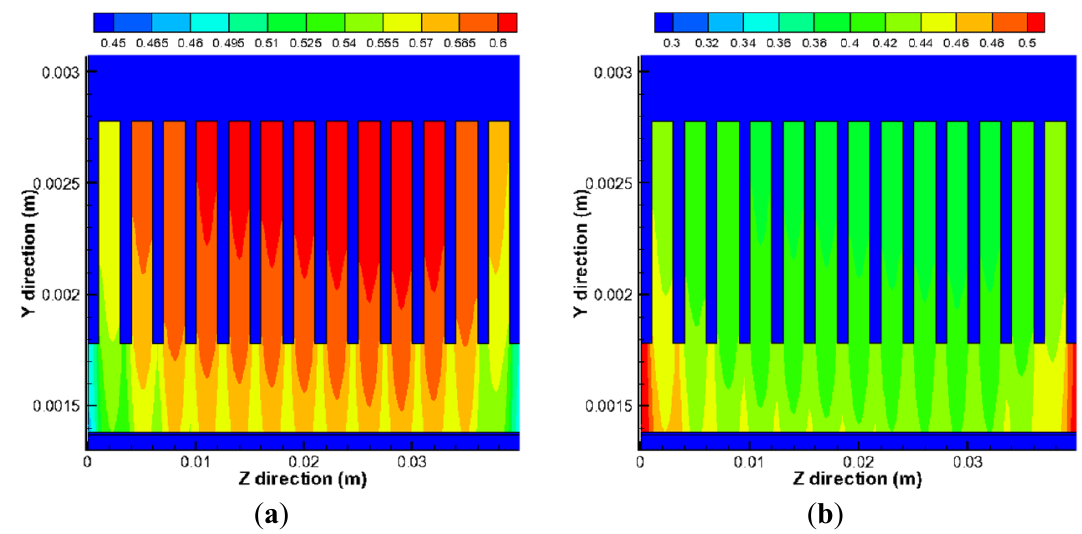
Figure 9. Mole fraction for a cross-section in the plane x = 0.03 m for: ( a ) H (not in